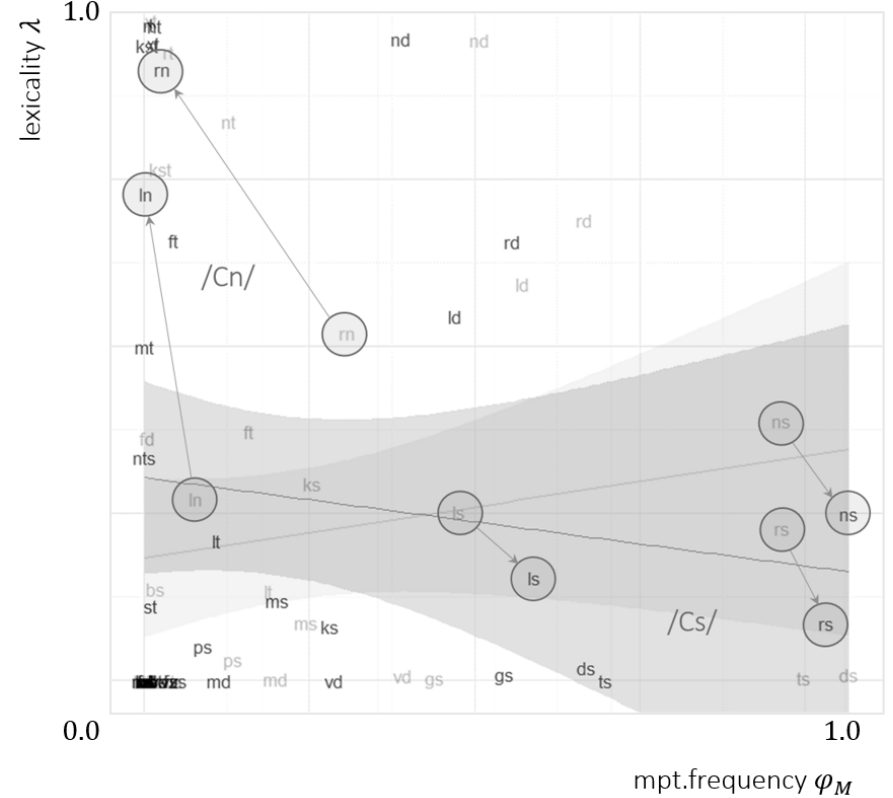
Figure 5. Plot of the superimposed morphonotactic spaces of the cluster inventories in the successive periods 1450–1500 (light gray labels) and 1500–1550 (dark gray labels), respectively. The horizontal axis was scaled in such a way that the respective maximal and minimal scores in both periods coincide. Linear regression models (solid lines) together with 95% confidence areas (gray) were added and illustrate a positive correlation in the 1450-­‐1500 period in contrast to a (not significant) negative correlation in the 1500-­‐1550 period. Circles indicate morphosyntactically relevant dynamics corresponding to a set of /Cn/ and /Cs/